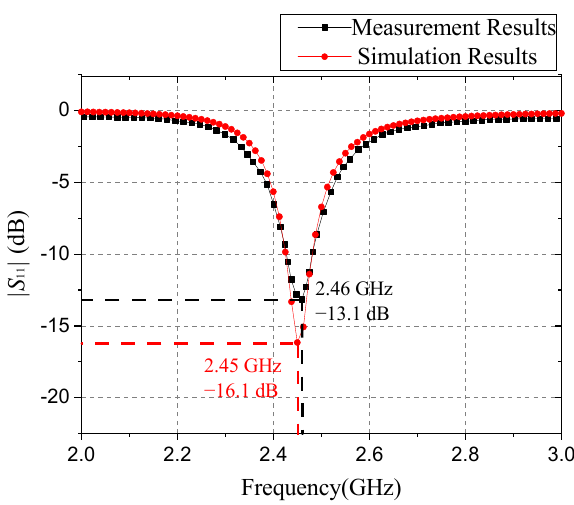
Figure 9. | S 11 | of simulation results and measurement results.